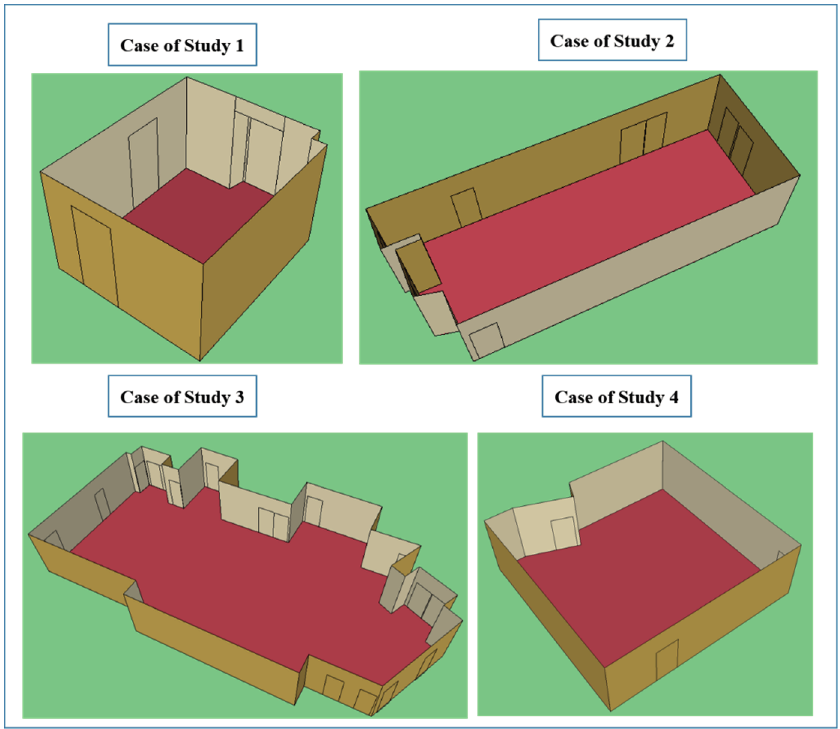
Figure 17. The resulting 3D building interiors visualized in Sketchup ©